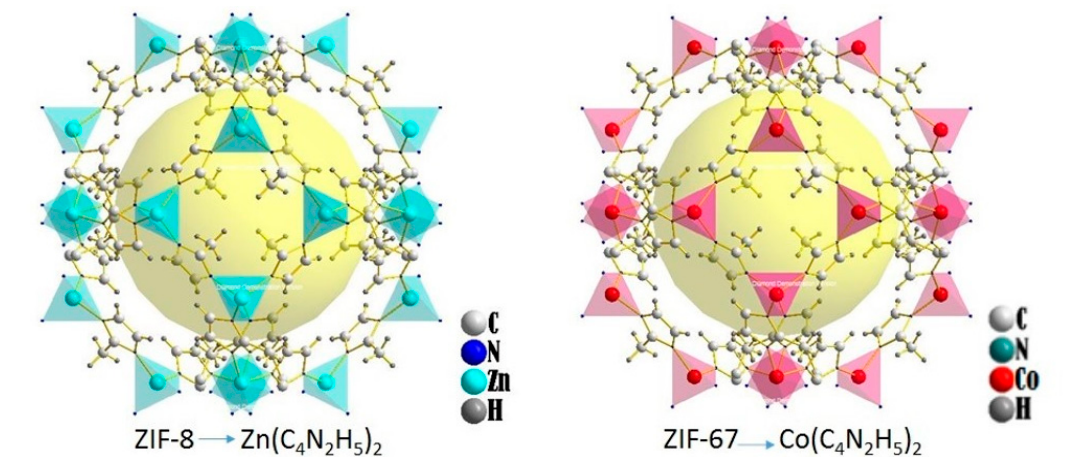
Figure 1. Representative crystal structures of ZIFs under study.